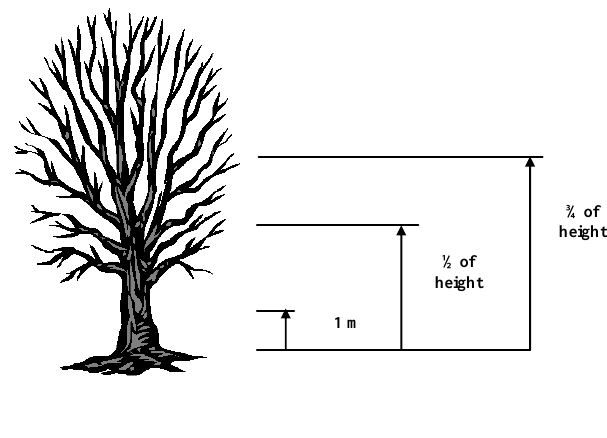
Fig. 2. Heights for cross-section sampling